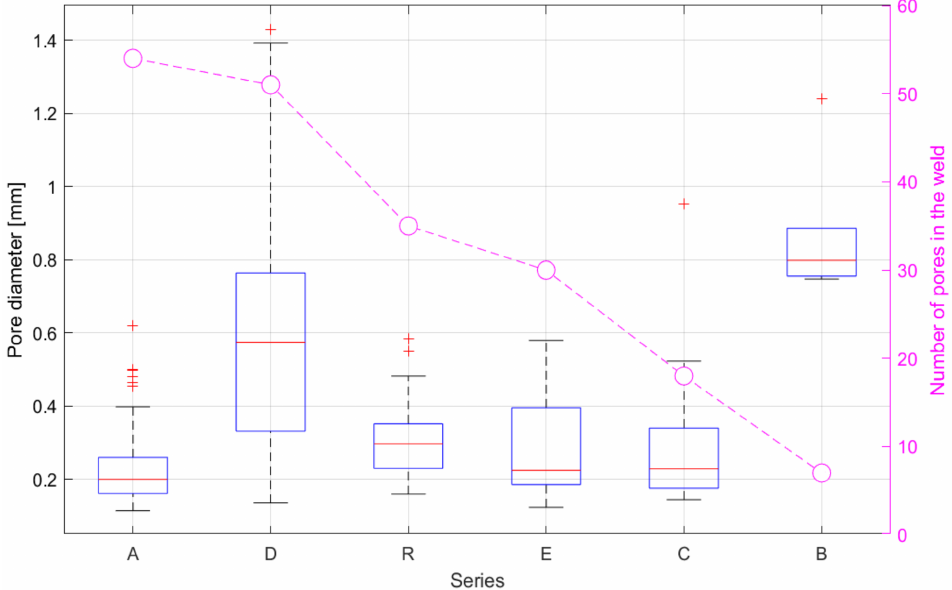
Figure 6. Number of pores and their pore diameter distribution from the second set of experiments.